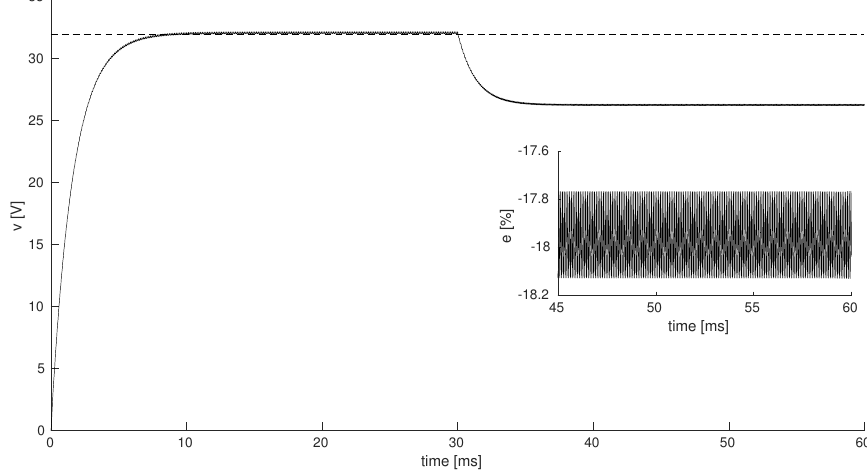
Figure 3. Time response of the capacitor’s voltage v . During the first 30 ms, the value of the resistor is set to R = 20 Ω , after this the load is changed to R = 18 Ω . Inset: Steady state percentage error (considered 15 ms after the presentation of the disturbance). The desired output is plot with the dashed line. Other details as in Figure